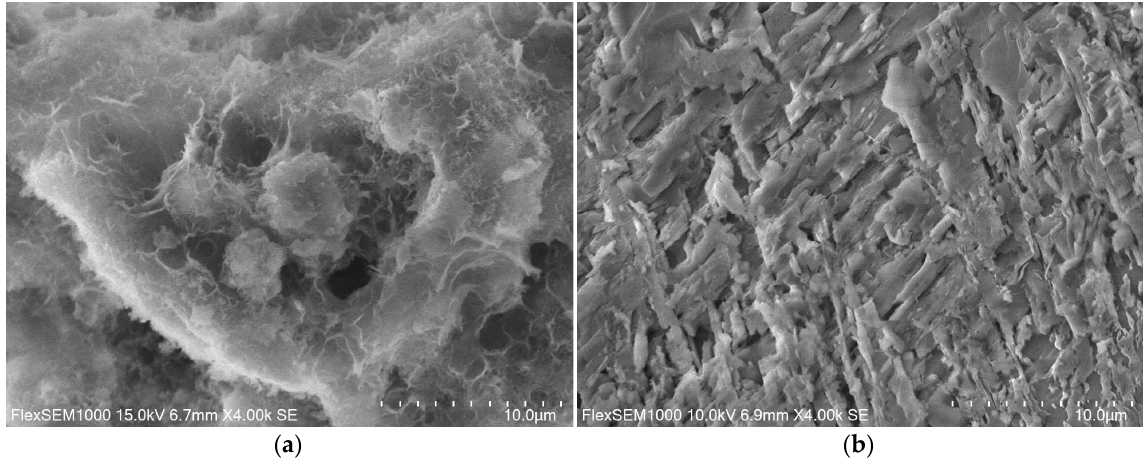
Figure 12. ZK1z10nc micrographs prepared in magnification of 4000×: ( a ) hardened paste microstructure; ( b ) growths on the slag grain surface.